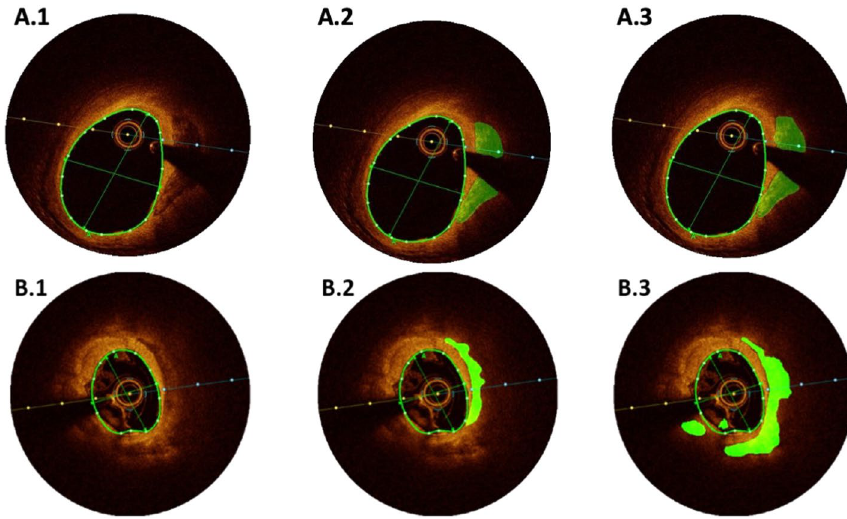
Figure 5. Visualize Results. Two examples of automated segmentation. ( A ) High accuracy of the model ( B ) Improved accuracy over manual annotation. (1) Original Image. (2) Manual annotation. (3) Automatic